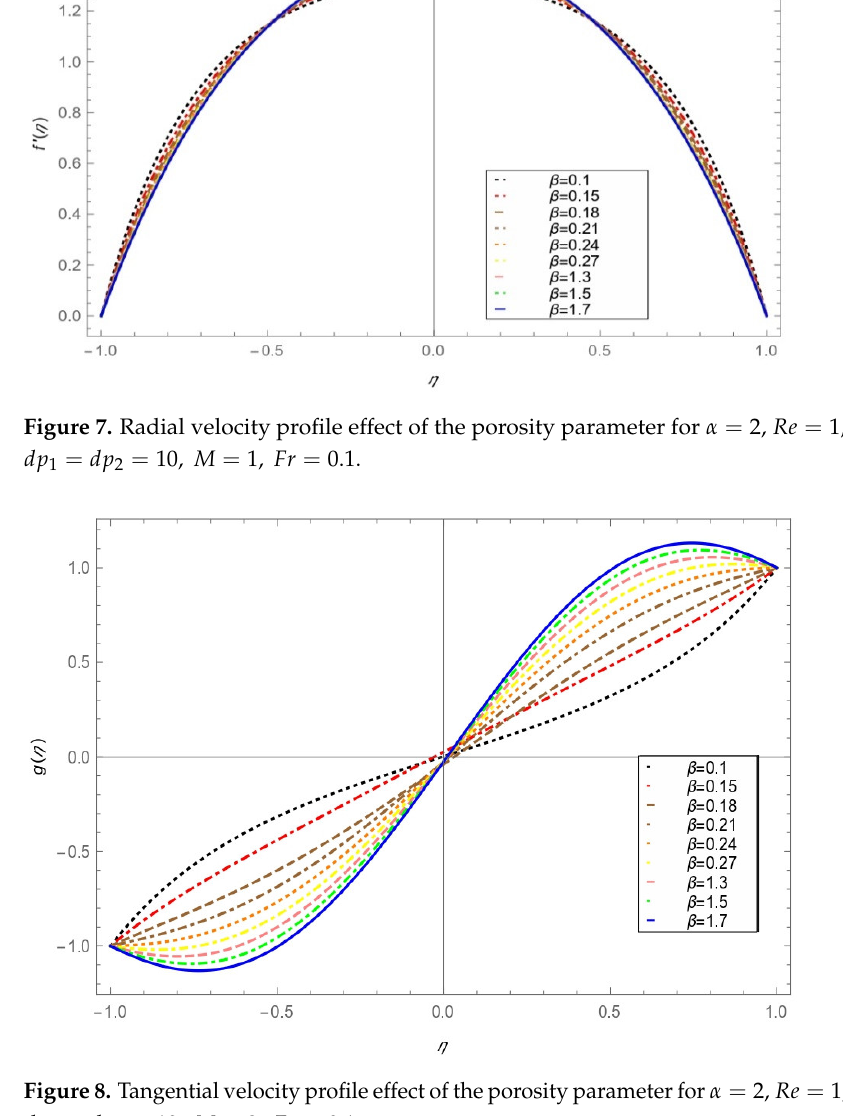
Figure 8. Tangential velocity profile effect of the porosity parameter for α = 2, Re = 1, ϕ 1 = ϕ 2 = 0.03, dp 1 = dp 2 = 10, M = 2, Fr = 0.1.